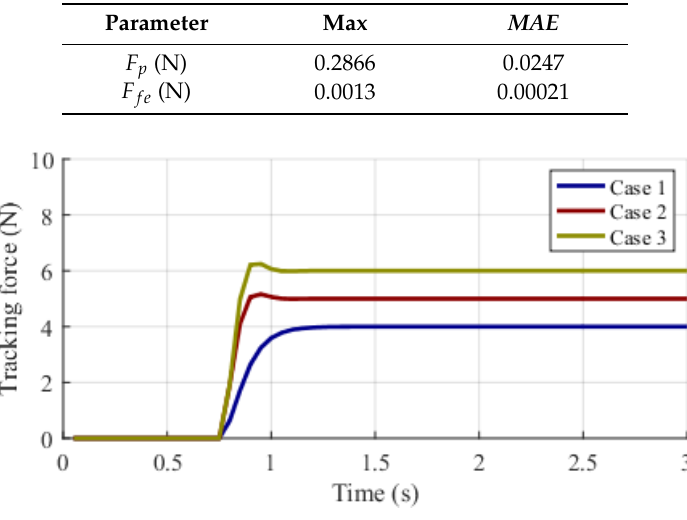
Table 2. The quality parameters on the testing data of simulation.